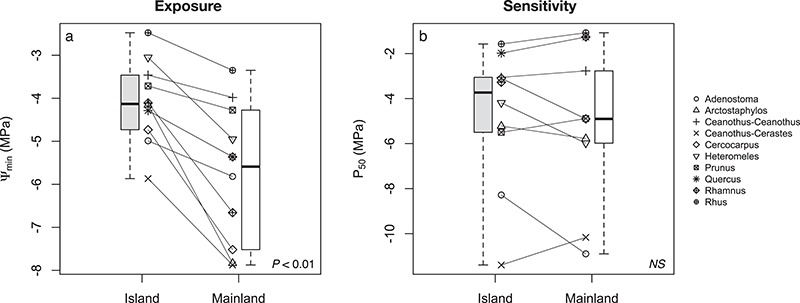
Minimum seasonal water potential (Ψmin; a) and cavitation resistance (P50; b) for island–mainland species pairs. These traits serve as proxies for exposure versus sensitivity to drought and are the components used to estimate hydraulic safety margins and provide a quantitative test of the conceptual model linking physiological trait patterns to detection of climate refugia (Fig. 1). P-values for paired statistical comparisons are depicted in the upper left corner of each plot.